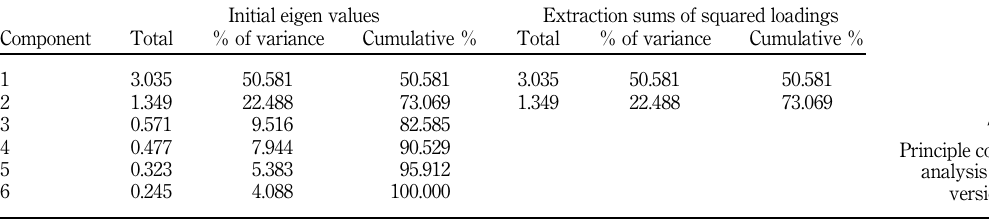
Table 2. Principle component